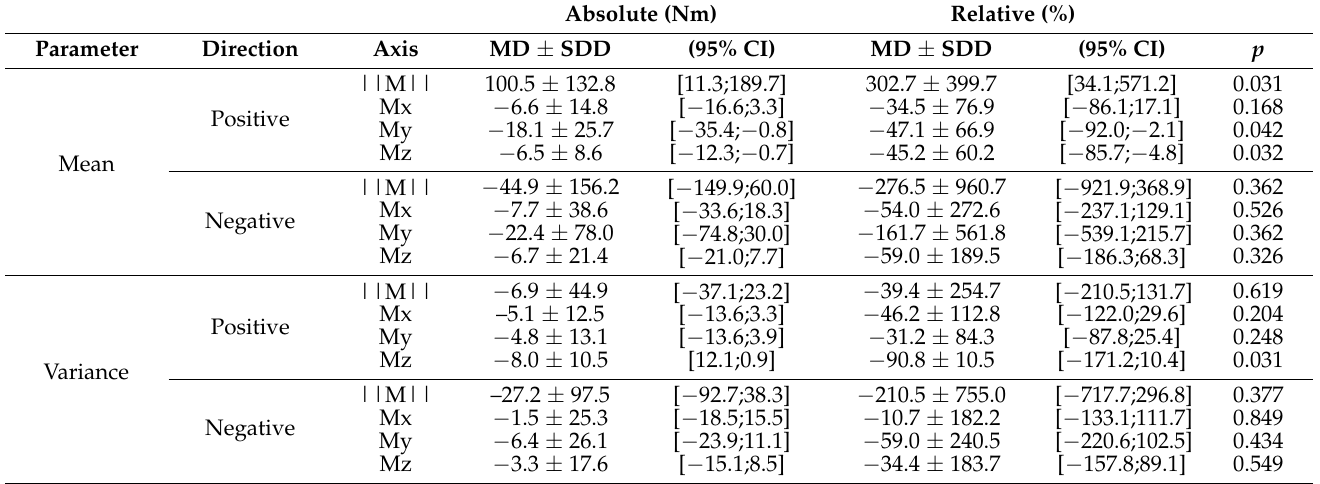
observed during rotation to the left around the longitudinal axis during dynamic tasks (MD = − 90.8 ± 10.5%, p = 0.031). In addition, significant differences in the mean moment (||M||, M y , and M z ) were observed in the positive direction ( − 47.1% ≤ MD ≤ 302.7%, p ≤ 0.042), but were not significant in the negative direction ( − 54.0% ≤ MD ≤ − 276.5%, p ≥ 0.326). Table 9. Direction of the net moment of magnitude and around the axis of the static vs. dynamic tasks. Shown are the absolute (Nm) and relative (%) differences between the static tasks and the dynamic tasks through mean difference (MD: static–dynamic) and its standard deviation (SDD) plus 95% confidence interval (CI). These are shown for the net moments around each of the three axes separately (in the right-handed axes frame): for the moments around the anterior–posterior axis (Mx), with the net moment positive for direction of rotation to the left; for the moments around the mediolateral axis (My), with the net moment positive in the forward flexion direction; for the moments around the longitudinal axis (Mz), with the net moment positive in the direction of rotation to the left and for the moment magnitude (||M||) with a p -value of paired t -test. Absolute (Nm) Relative (%)